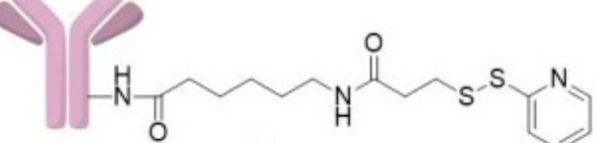
Figure 6. PAMAM G5-Sulfo- LC-SPDP ( 4 ). The CRL-2314 cells were treated with 100 µL of thioether cross-linked dendrimer conjugate Trastuzumab derivative ( 5 ) (Figure 7). Figure 7. Thioether cross-linked dendrimer conjugate Trastuzumab derivative ( 5 ). 1.3. MTT Assay